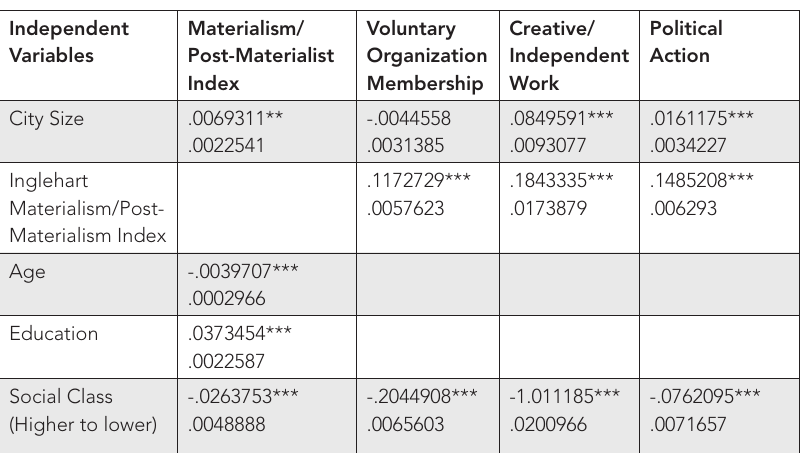
Table 4: Mixed Effects Post-Materialism and Post-Material Experience Regressions and City Size (Coefficients and Standard